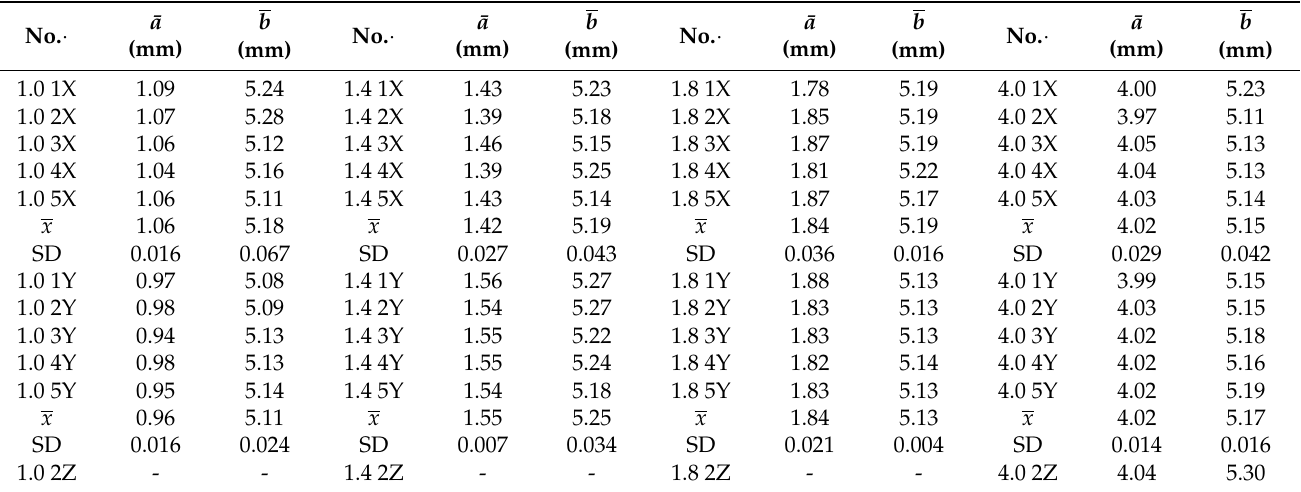
Table 2. Dimensions of the PLA + bronze specimens prior to tensile